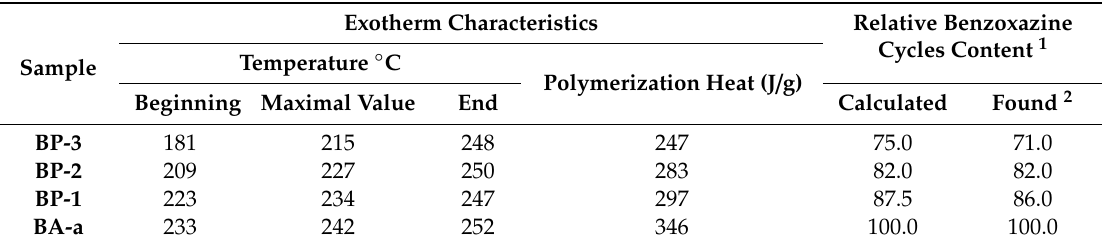
Figure 9. DSC curves of curing of benzoxazine BA-a and phosphazene-containing benzoxazines. Table 4. DSC results of benzoxazines in the curing